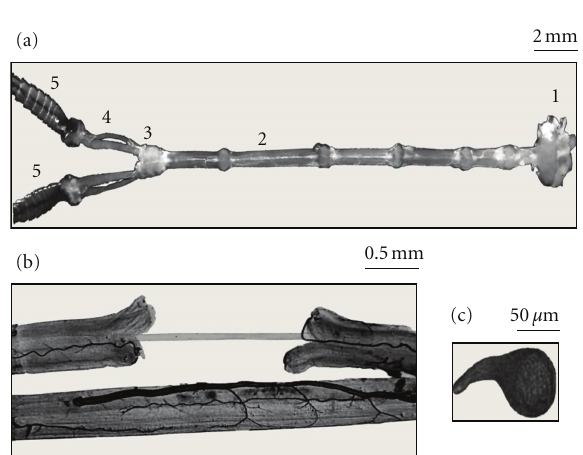
Figure 1: Cockroach ( Periplaneta americana ) nervous system. (a) Isolated abdominal nerve cord with last thoracic (1) ganglion and cercal nerves (4) linked to cerci (5). Giant axon is isolated from one connective between the 4th and the 5th ganglion (2). DUM neurons and cercal nerve-giant interneuron synapses are located in last abdominal ganglion (3). (b) Isolated giant axon dissected from one connective, accompanied by the second connective which protects the axon when the preparation is transferred to experimental chamber; axon diameter ∼ 50 μ m. (c) Isolated DUM